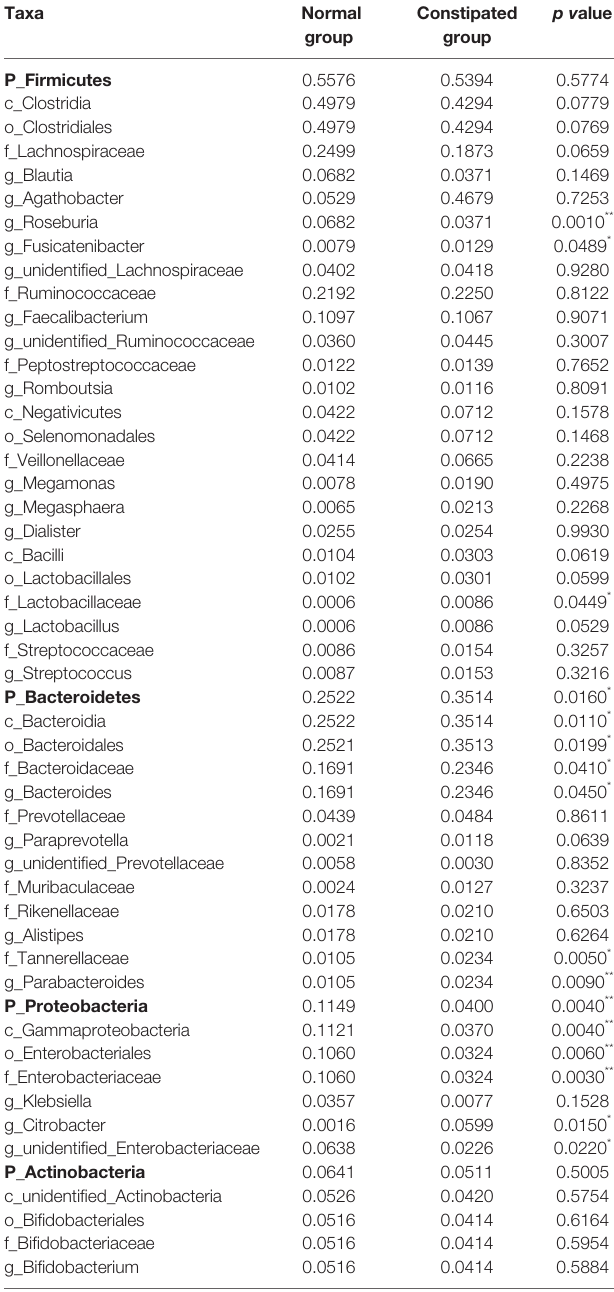
The normal group shows the average abundance of gut microbiota in healthy control subjects, n ＝ 30. The constipated group shows the average abundance of gut microbiota inconstipatedwomenofreproductiveage,n ＝ 29.pvaluescalculatedfromttestorMann- Whitney U test. Pre fi xes p_, c_, o_, f_, and g_ refer to phylum, class, order, family, and genus. *p < 0.05; **p <